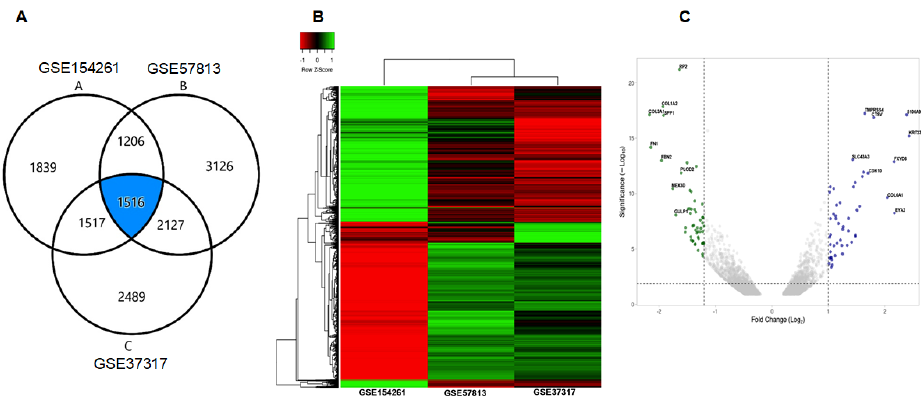
Figure 1. Identification of differentially expressed genes (DEGs) between 3 datasets. ( A ) Venn- diagram exhibiting three database GSE154261, GSE37317 and GSE57813 showing common DEGs associated with bladder cancer. ( B ) The composite heat map of three datasets. ( C ) The volcano plot of the three datasets.